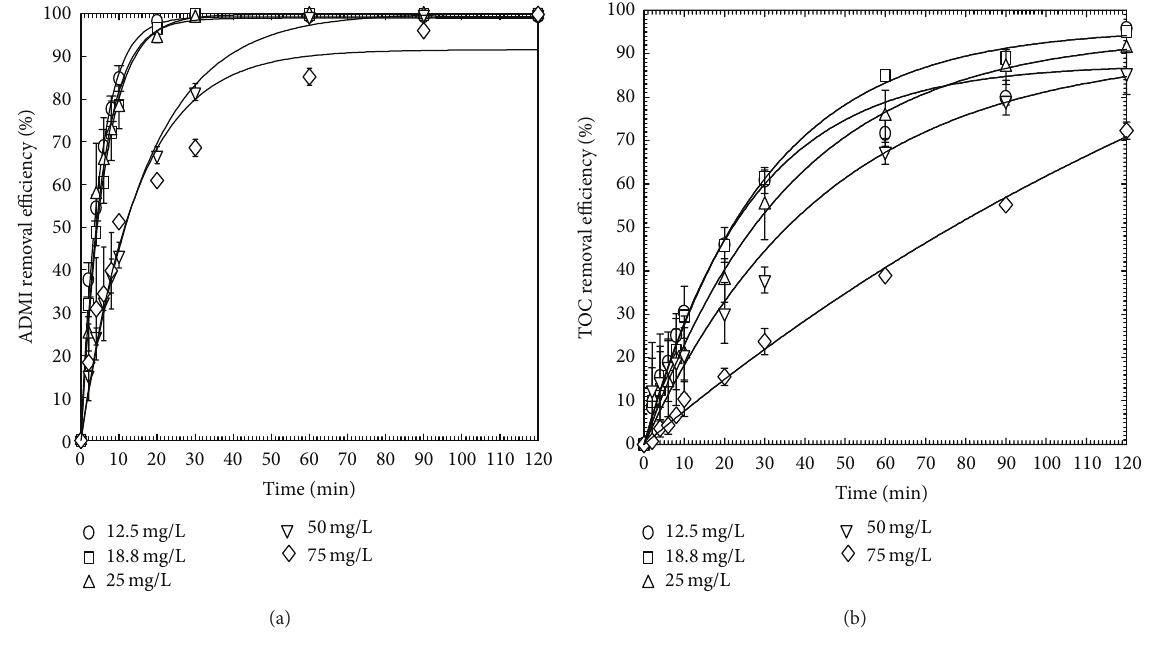
Figure 7: Effect of initial concentration on (a) ADMI color and (b) TOC removal. The conditions were ZnO-coated amounts of 60gm −2 , light intensity of 2.1mWcm −2 , and reaction time during